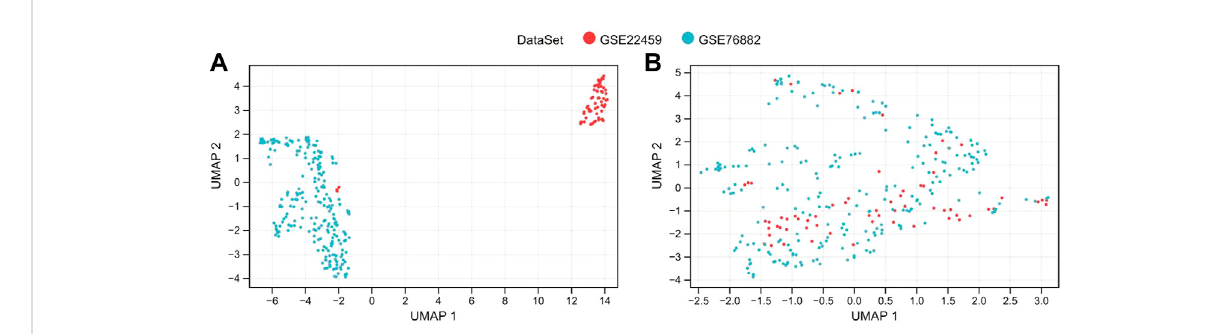
FIGURE 1 De-batch analysis. (A,B) are the sample step-by-step diagrams before and after de-batching, respectively.